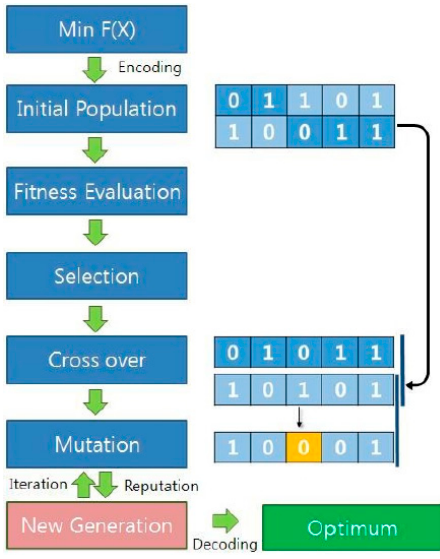
Figure 7. Process of GA algorithm.